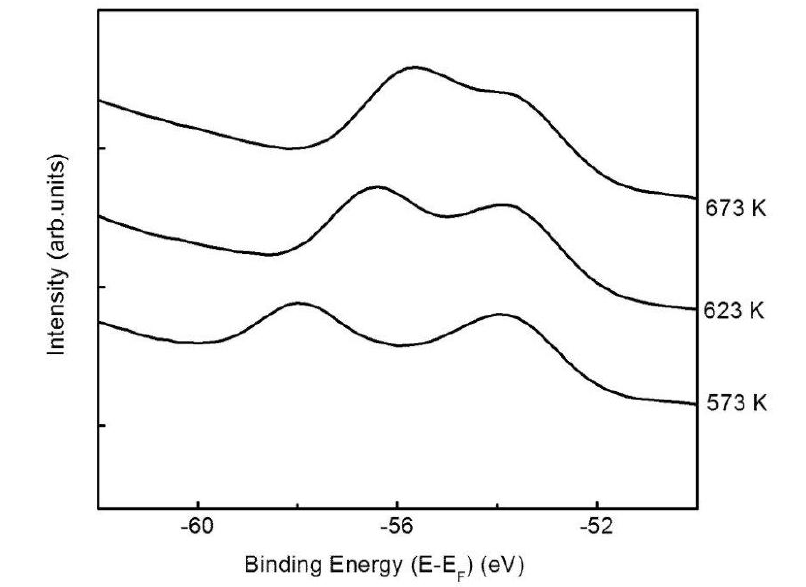
Figure 11. The change in the surface-to-core bulk core level shift with decreasing temperature indicative of differences in the surface photovoltaic charging at the surface and bulk for the Li B O (110) 2 4 7